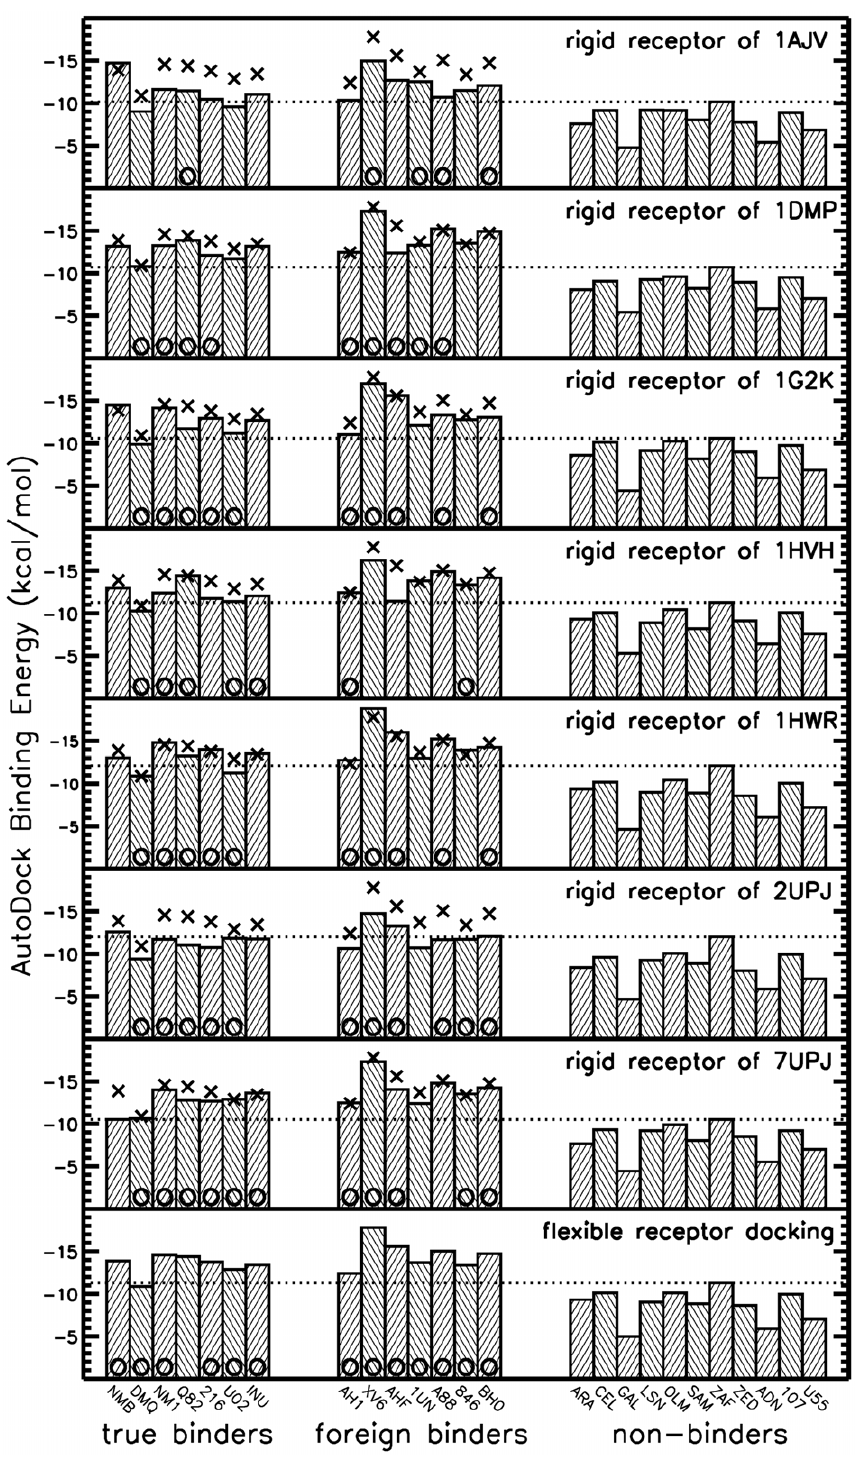
Figure 6. Binder non-binder discrimination by scoring energies. Best scoring results for docking of true, foreign and non-binders upon docking to 7 different rigid receptor structures and using flexible receptor docking (using interpolation between the 7 receptor structures). The dotted line marks the best binding energy obtained for the non-binder molecules (corresponds to the limit for distinguishing binders from non-binders). The cross symbols indicate the results of flexible receptor docking and are included for comparison for each docking to a rigid protease receptor (upper 7 rows). The O symbols are present at the bottom of each bar, if the respective best energy docking solution also yields an RMSD ligand , 2A˚.